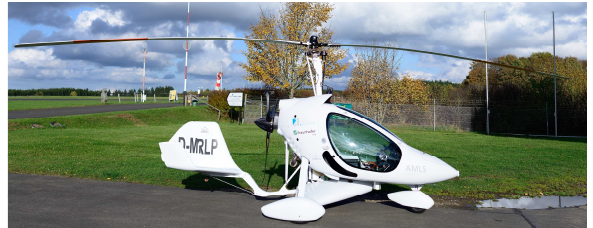
Figure 1. CloudDancer II (D-MRLP) of AMLS, based at the airfield Dahlemer Binz (Eifel).